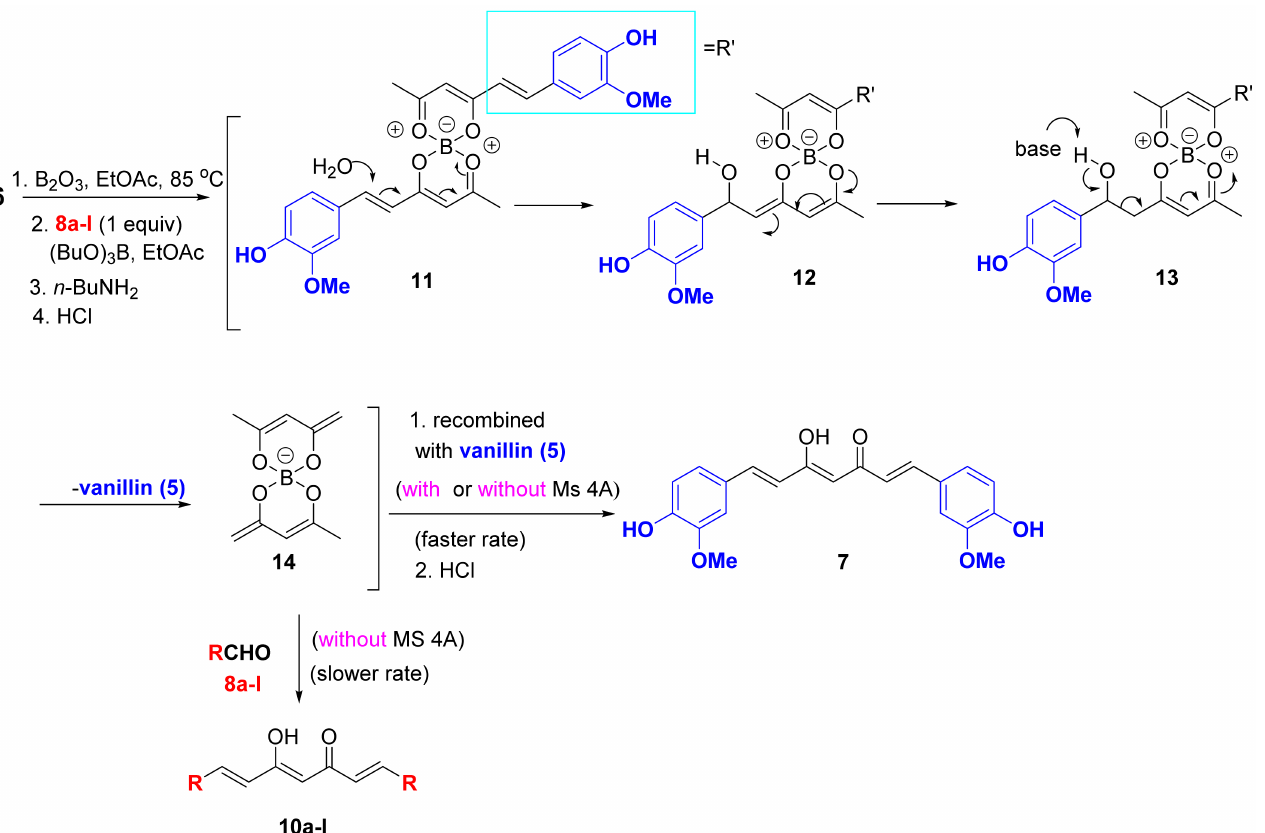
Figure 4. Plausible mechanism of the formation of by-products 7 and compounds 10a – l for the synthesis of asymmetric curcuminoids 9a – l